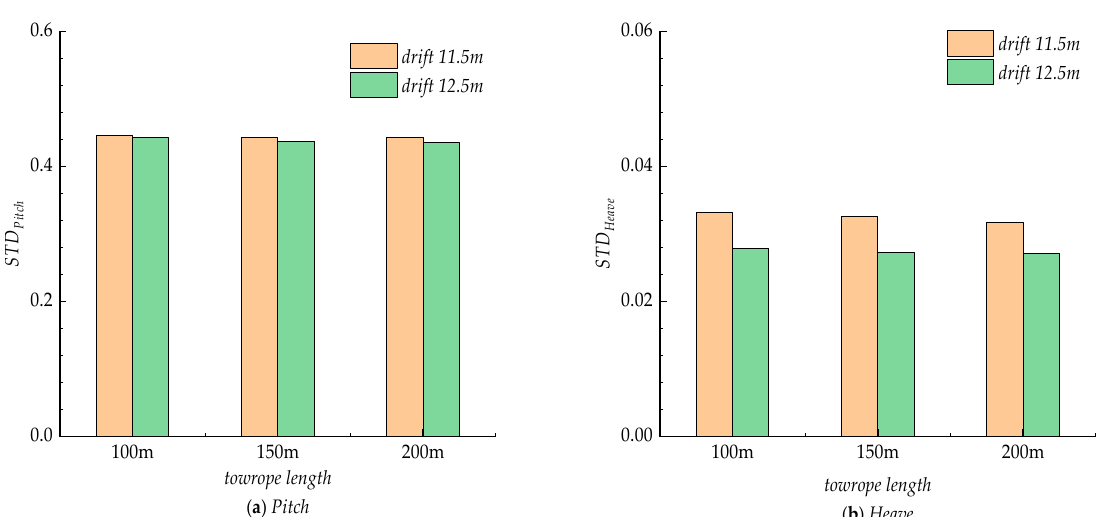
Figure 14. STD of dynamic responses at different drift depths and towrope lengths.